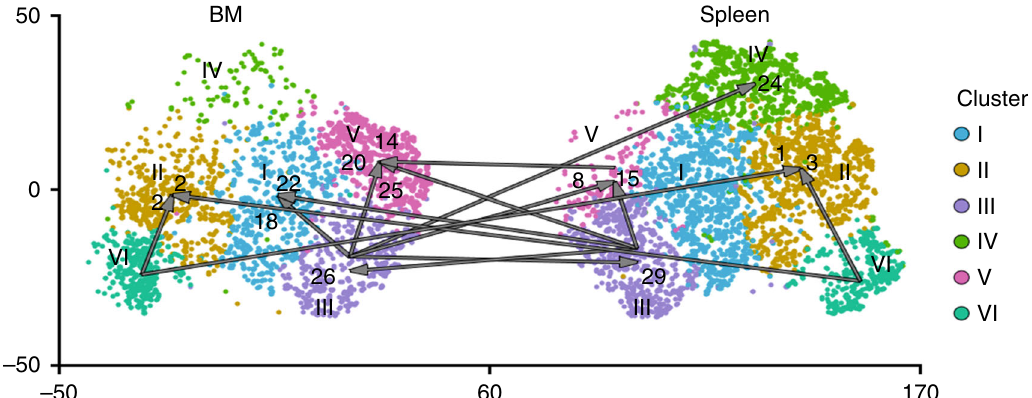
Fig. 5 Clonal trajectories connect predominantly clusters III and V of spleen and bone marrow. a Percentage of shared clones between clusters of spleen and bone marrow. Clones were de fi ned according to IgG heavy and light chain genes. Clones were randomly redistributed to clusters. Overlap signi fi cantly higher than random ( P < 0.05, randomization test) indicated by red shading, white represents expected random overlap, and blue shading overlap lower than random, i.e., exclusive repertoires. b Mutation rates (percent of nucleotide sequence; upper panel) and CD80 ( Cd80 ), CD73 ( Nt5e ), and PD-Ligand 2 ( Pdcd1lg2 ) gene expression of individual cells. Cells for single cell sequencing were isolated by FACS as IgG + CD19 + CD38 + CD138 − GL7 − small lymphocytes. c Frequencies of Bsm clones represented with higher mutation rates in clusters listed in rows, as compared to clusters listed in columns. Signi fi cant presence of clone members with additional mutations as compared to random distribution ( P < 0.01, randomization test) is shaded in red. d Trajectories are based on accumulation of mutations within clones. Represented are signi fi cant trajectories ( P < 0.01, randomization test). Arabic numerals indicate numbers of clones with additional mutations. Randomized redistribution of clones was performed 1000 times ( a , c , d ). Source data is provided as a Source Data fi